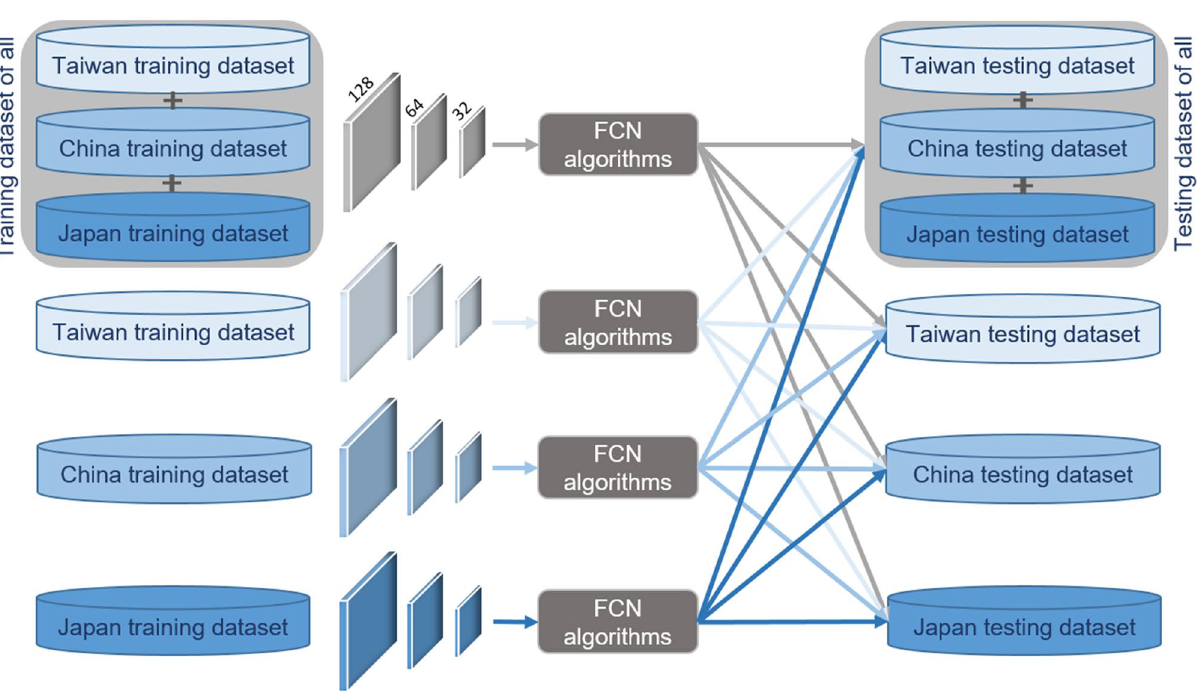
Figure 5. The scheme summarizing the four different scenarios in this